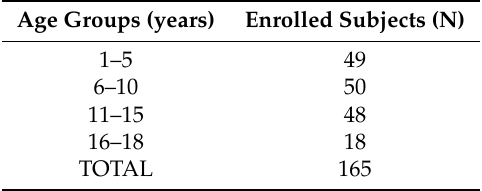
Table 1. Age groups of the study